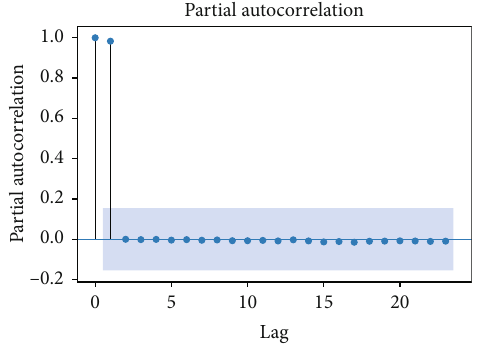
Figure 14: Partial autocorrelation for cumulative oil.